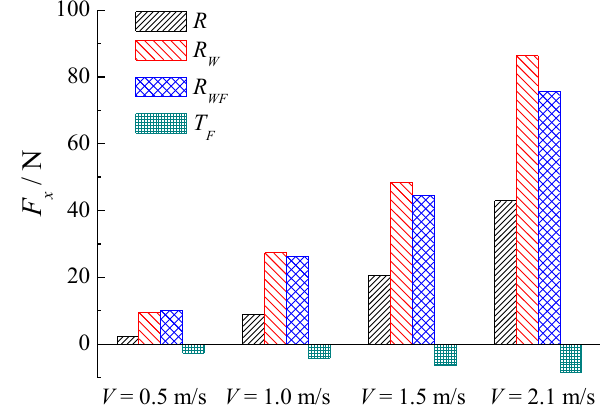
Figure 14. Mean axial force F x acting on the hull and bow foil. Table 5. The hydrodynamic force defined in Figure 13.